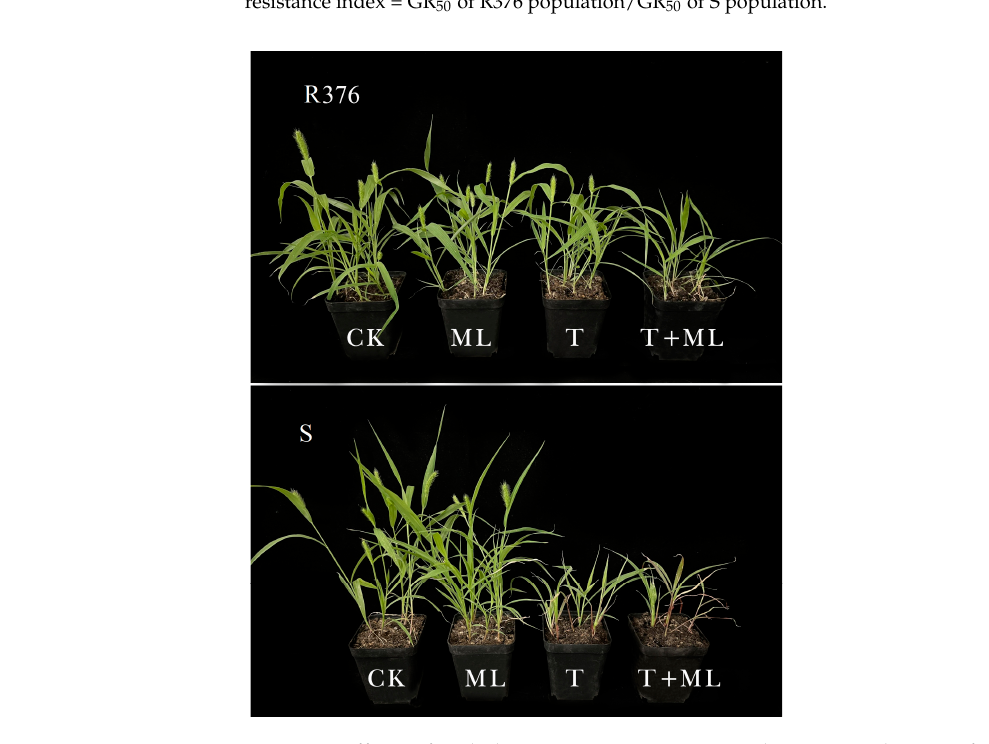
Figure 2. E ff ects of malathion pre-treatment in S and R376 populations of S. viridis . CK, ML, T, and T + ML represent the treatment of water, malathion, nicosulfuron (30 g a.i. ha − 1 ), and malathion + nicosulfuron (30 g a.i. ha − 1